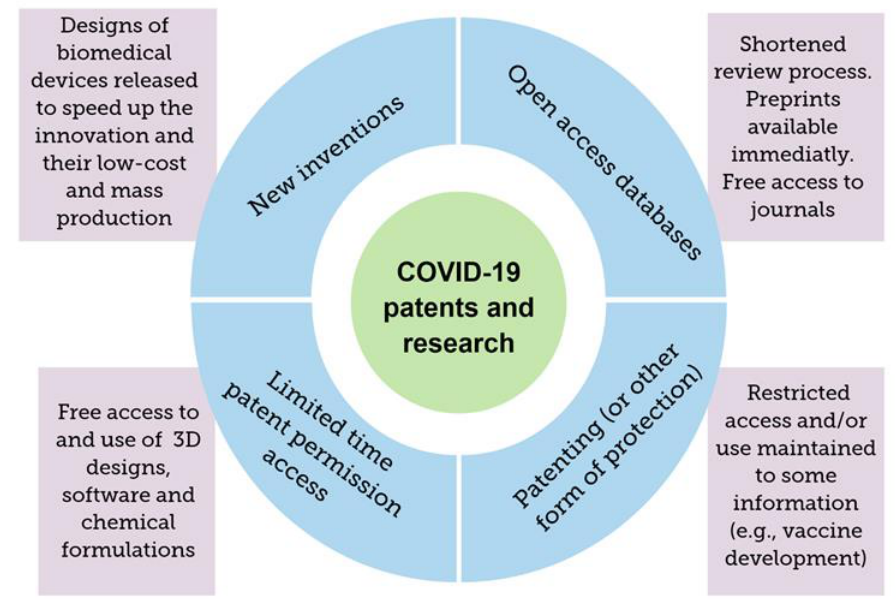
Figure 2. Dissemination and use of research about COVID-19: research and development and access to patents.